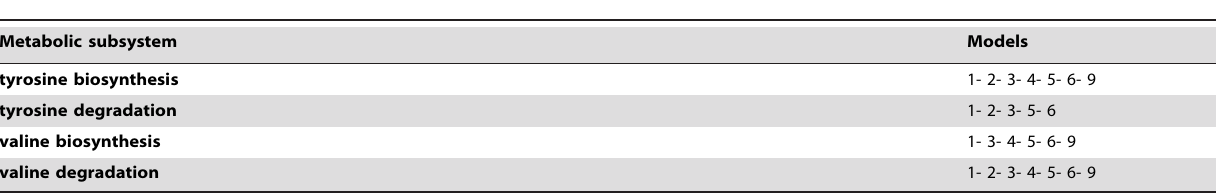
Table 3. Decreased flux range of yeast metablic subnetwork in the 9 mutated histone tail models.